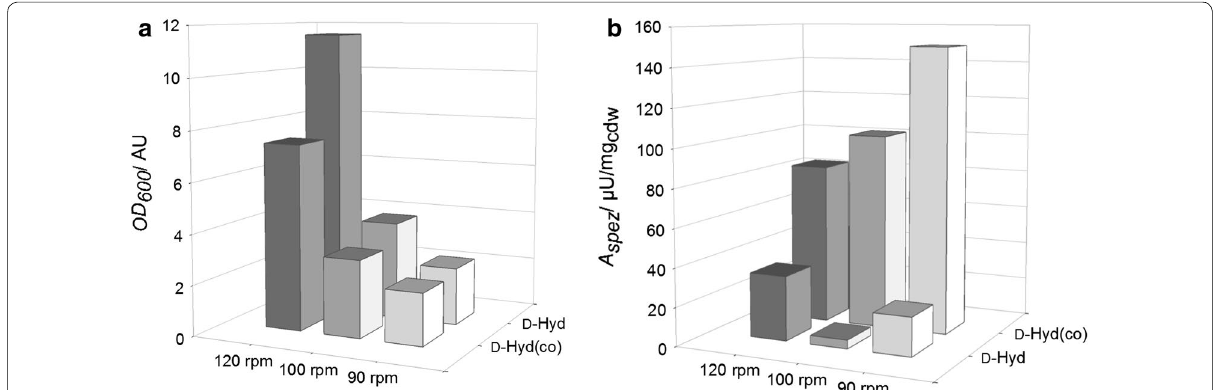
Fig. 2 Cultivation of E. coli BL21DE3 and expression of d -Hyd and d -Hyd(co) under oxygen deficiency. a OD 600 values of the d -Hyd and d -Hyd(co) cultures at the moment of harvesting after cultivation at 120 rpm ( dark grey ), 100 rpm ( grey ) and 90 rpm ( white ). b Specific activities of d -Hyd and d -Hyd(co) during whole cell biotransformations with 2 mM PheHyd as as substrate. The reactions were carried out at 40 °C and 800 rpm in Tris–HCl (50 mM, pH